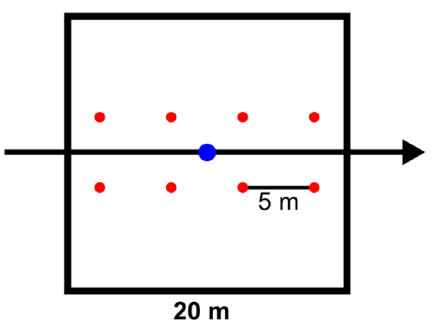
Figure 3. Sampling scheme for digital hemispherical photography. Shown are a sampling reference point (blue) and eight DHP acquisition spots covering the corresponding Sentinel-2 pixel area (20 × 20 m).